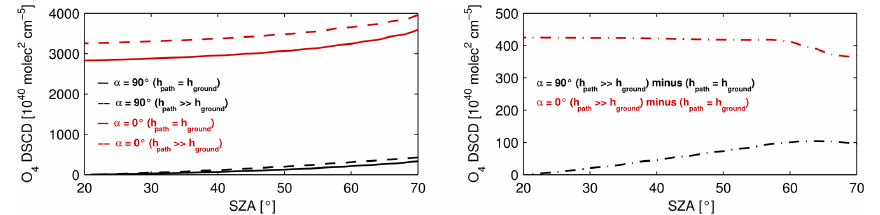
Figure 3. Simulated O 4 DSCDs (346–372nm fitting window) at the Pico Espejo site (left) for α = 0 ◦ (red) and α = 90 ◦ (black), where the solid ( h path = h ground ) and dashed ( h path (cid:29) h ground ) lines denote the two different scenarios as described in the text and shown in Fig. 1. The absolute differences between the two scenarios are shown in the right panel for the horizontal and vertical viewing direction.